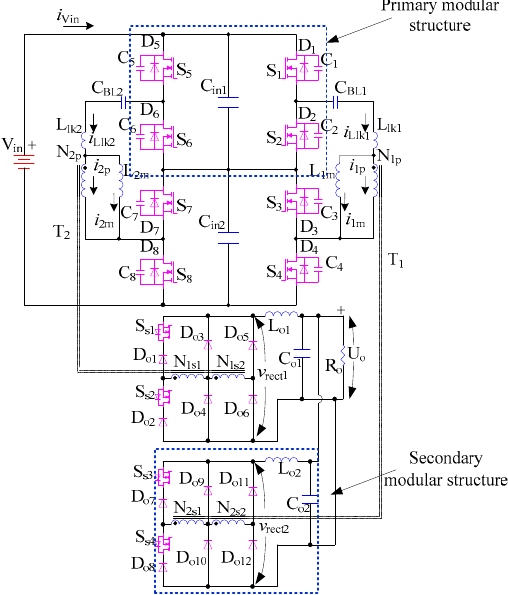
Figure 2. Proposed high voltage zero-voltage switching (ZVS) dc-dc converter with redundancy